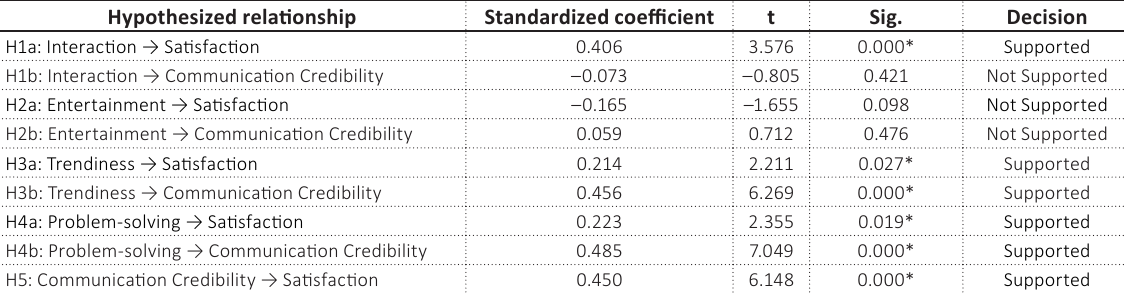
Table 4. Structural model and hypothesis